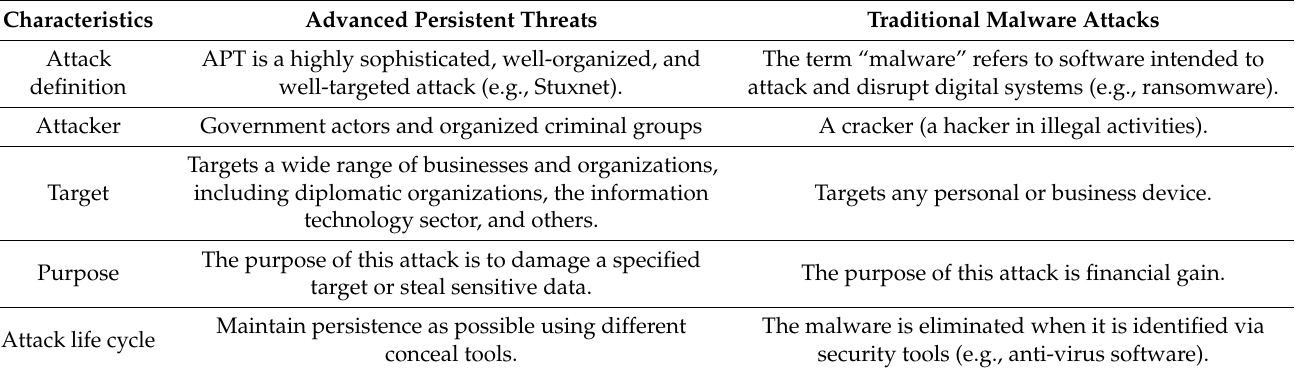
Table 1. Differences between APTs and traditional malware